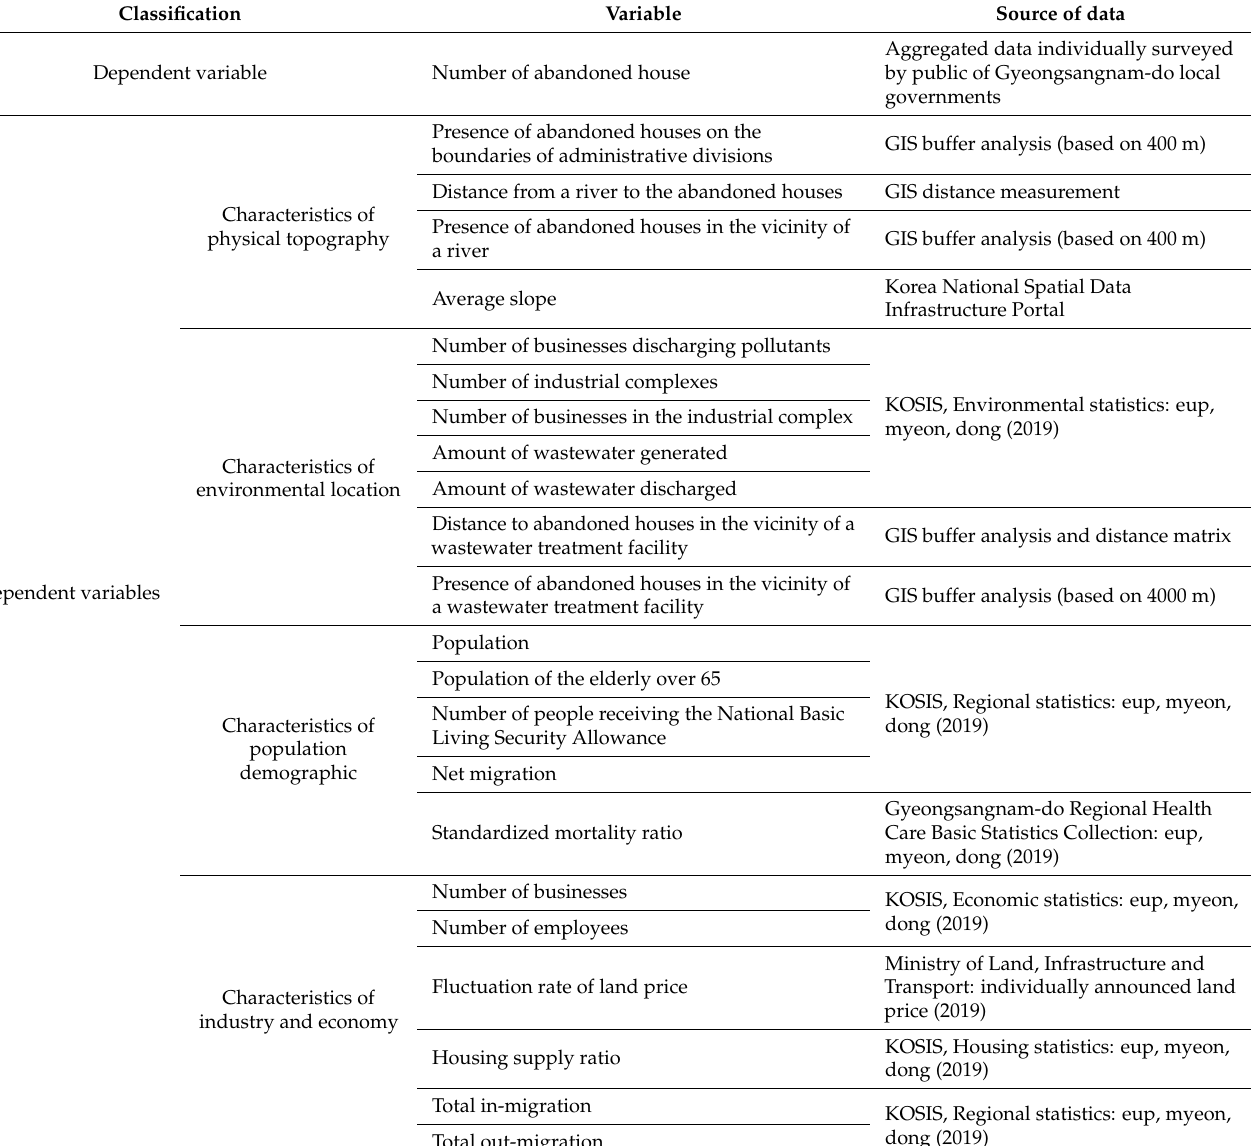
Table 2. The selected